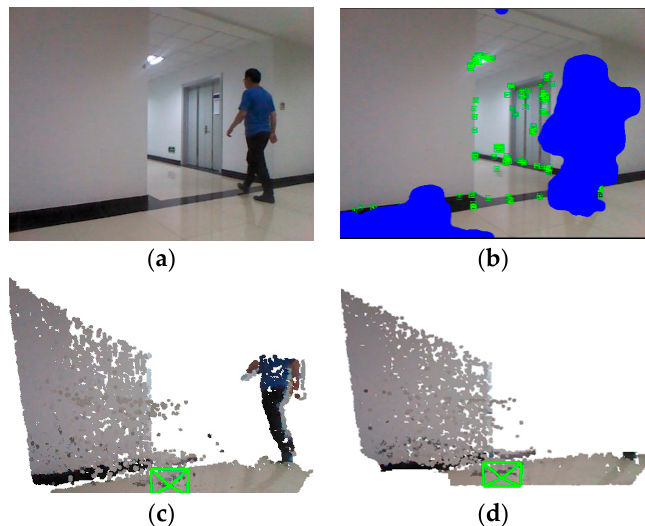
Figure 8. Dynamic object culling based on optical flow method. ( a ) Original RGB image, ( b ) dynamic object culling in RGB image, ( c ) corresponding point clouds generated by original depth data, and ( d ) dynamic object culling in depth data.